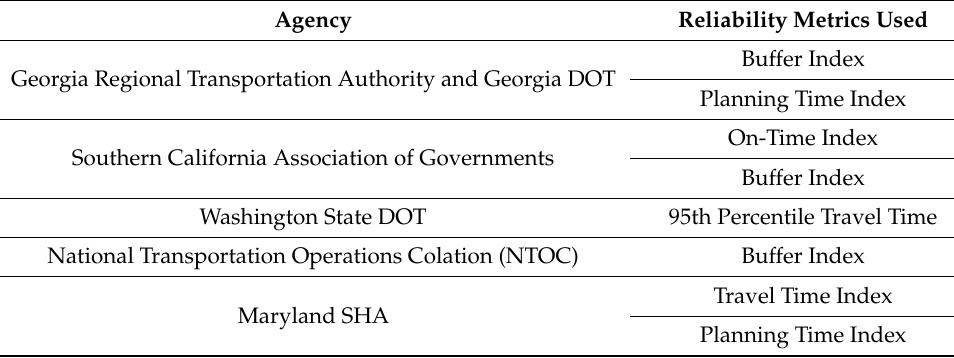
Table 1. Reliability metrics used by selected US transport